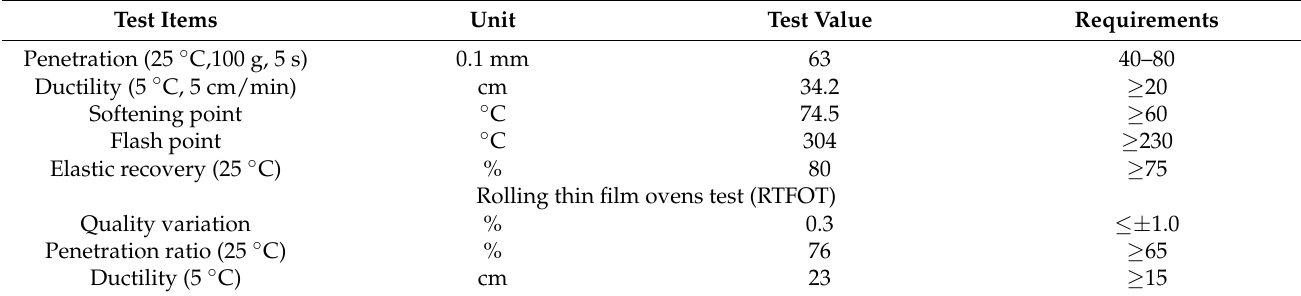
Table 1. Basic properties of SBS ‐ modified asphalt.